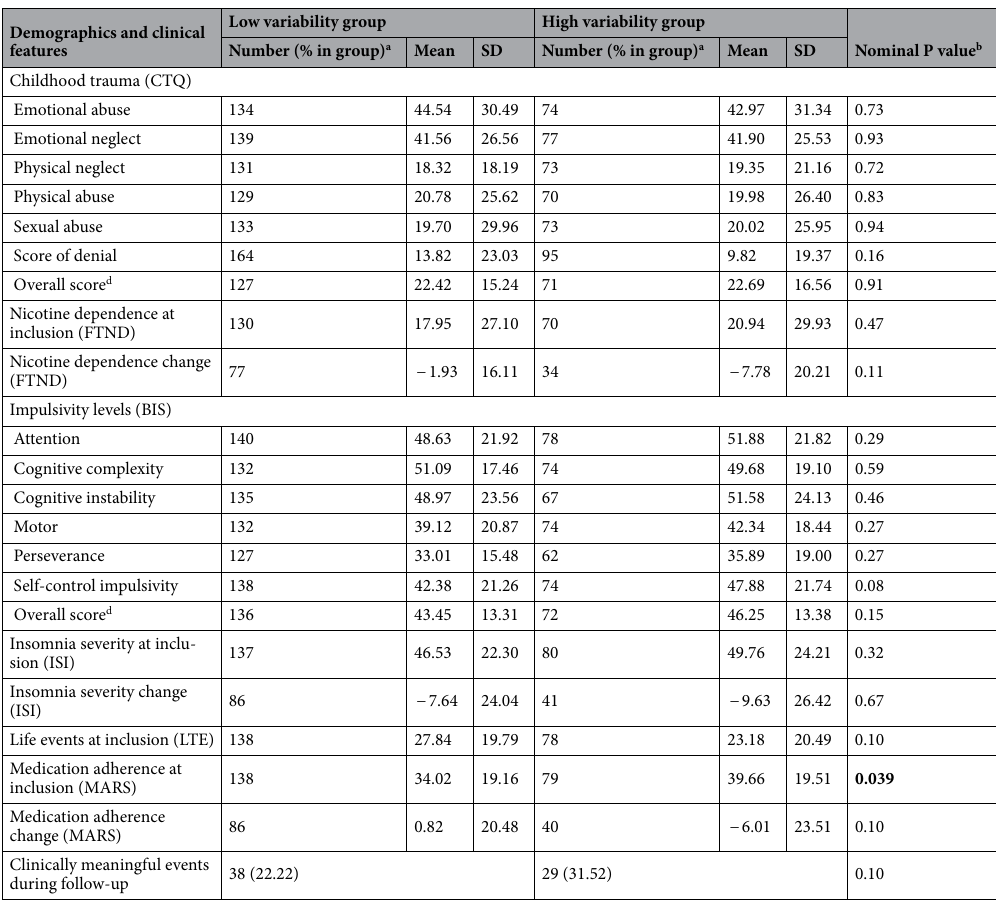
of patients in the two groups may not add up to 275 due to missing data. b Since no statistical difference is found after correcting for multiple comparisons, only the nominal P values are shown. c Diagnoses representing < 1% of the sample are not shown. d Items shown for completeness, but not considered neither for the classification with random forest nor for the multiple comparison correction. Nominal P values strictly smaller than 0.05 are marked in